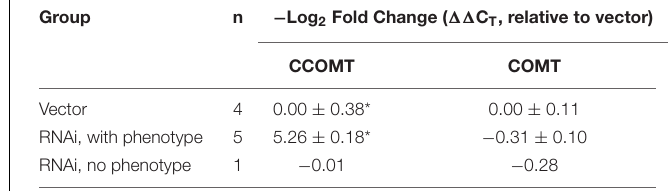
TABLE 6 | Real-time PCR analysis of CCOMT and COMT expression.